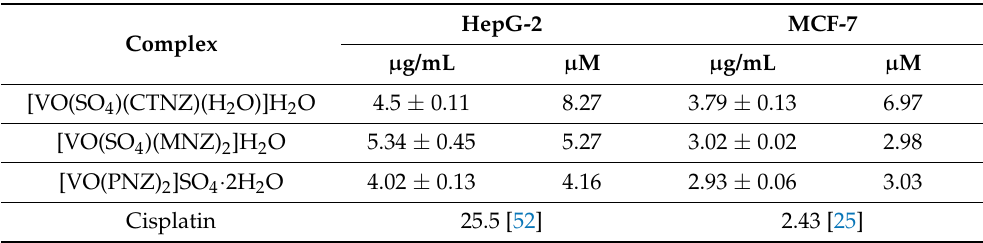
Table 8. IC 50 for tested compounds against different cell lines compared to cisplatin in different units, IC 50 ± SD ( µ g/mL) and µ